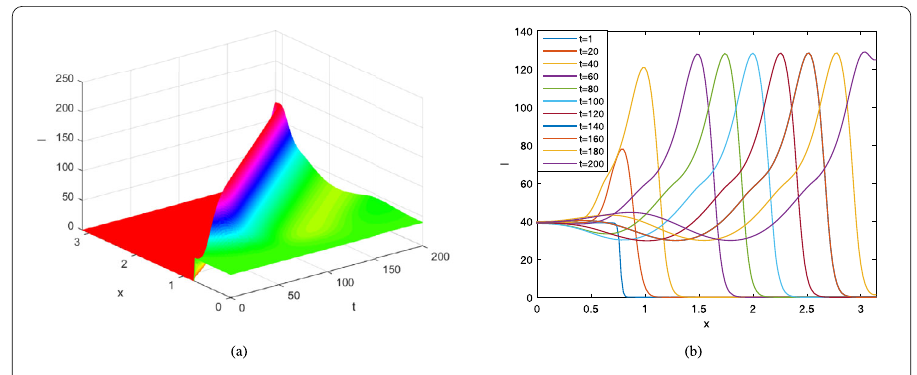
Figure 7 Traveling waves of system (2.1) in the case 1 < R 0 < R c . ( a ) Solutions I ( x , t ); ( b ) Solutions I ( x , t ) are in terms of different t